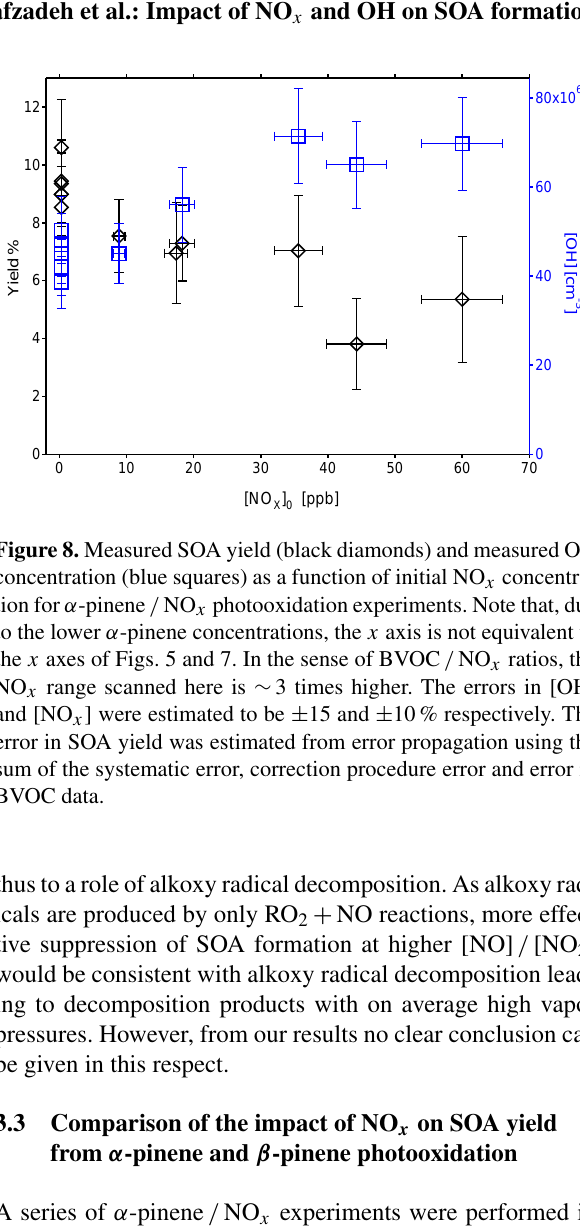
Figure 7. Comparison of SOA yield before (black circles) and af- ter (blue circles) adjusting OH concentration during steady state in NO x experiments performed under lower [NO] / [NO 2 ] ratio. The error in [NO x ] was estimated to be ± 10% and the error in SOA yield was estimated from error propagation using the sum of the sys- tematic error, correction procedure error and error in BVOC data.